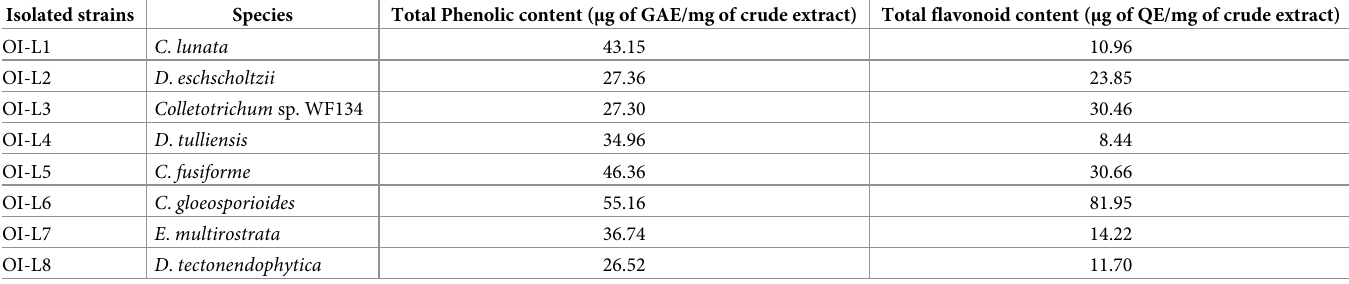
Table 1. Total phenolic and flavonoid content present in EA extract of identified fungal endophytes associated with the leaf of O . indicum . Isolated strains